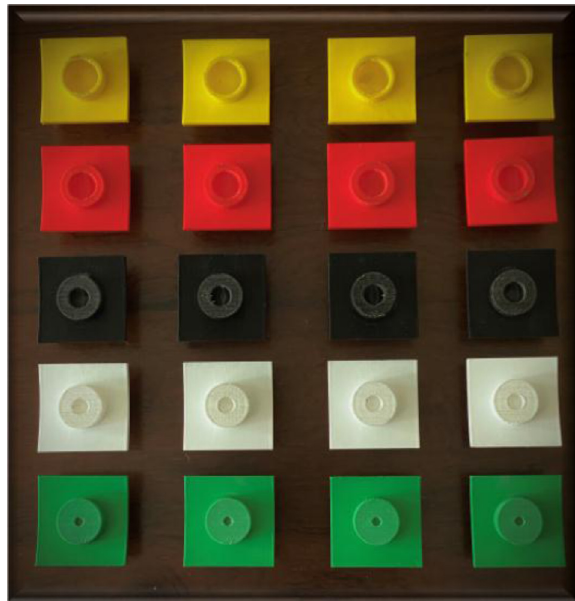
Fig. 12. 3D printed synthetic discontinuities.